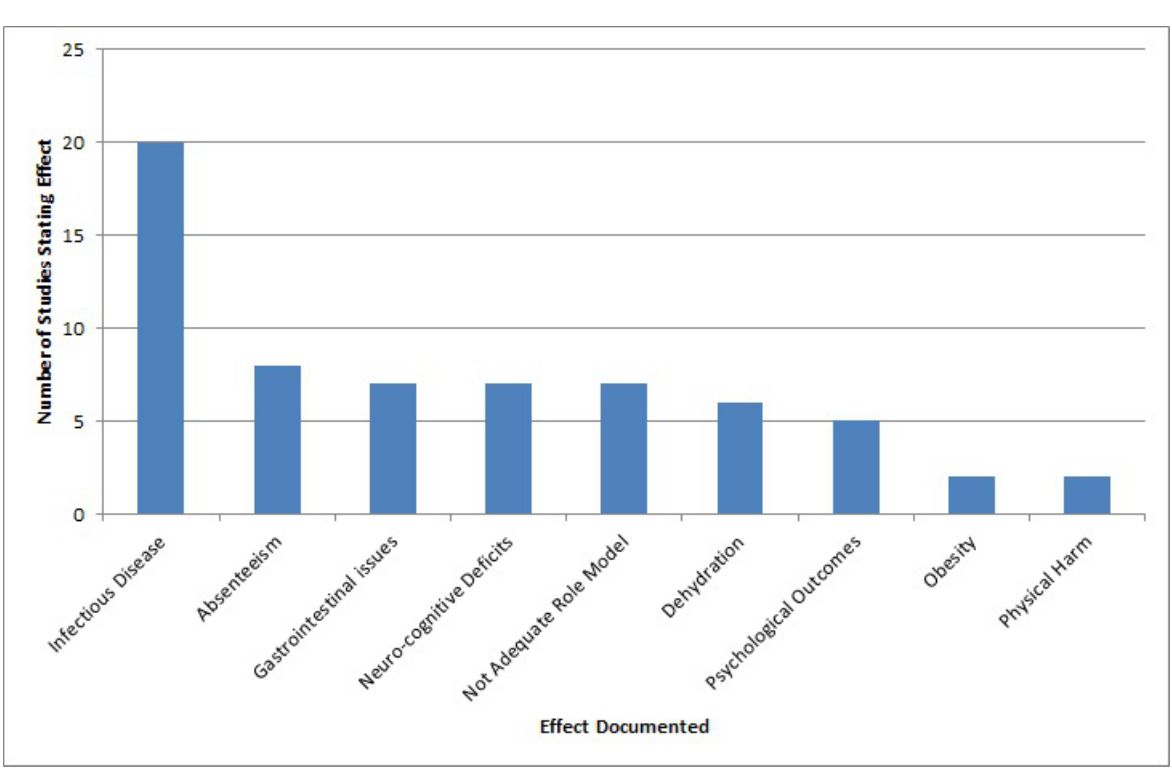
Figure 2. Effects catalogued in included studies (n =